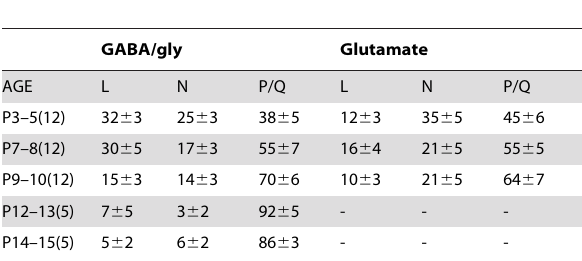
Table 3. Percent contribution of different VGCC subtypes to GABA/gly and glutamate